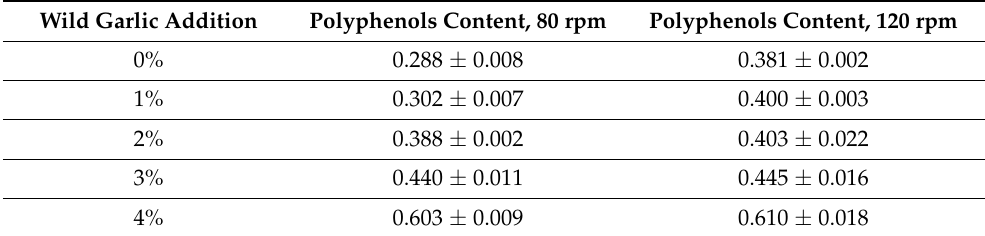
Table 1. The total content of polyphenolic compounds (TPC mg GAE/g d.w.) in snacks enriched with wild garlic extruded at two different screw speeds—80 and 120 rpm (n = 3; mean ± SD). Wild Garlic Addition Polyphenols Content, 80 rpm Polyphenols Content, 120 rpm 0% 0.288 ± 0.008 0.381 ± 0.002 1% 0.302 ± 0.007 0.400 ± 0.003 2% 0.388 ± 0.002 0.403 ± 0.022 3% 0.440 ± 0.011 0.445 ± 0.016 4% 0.603 ± 0.009 0.610 ±